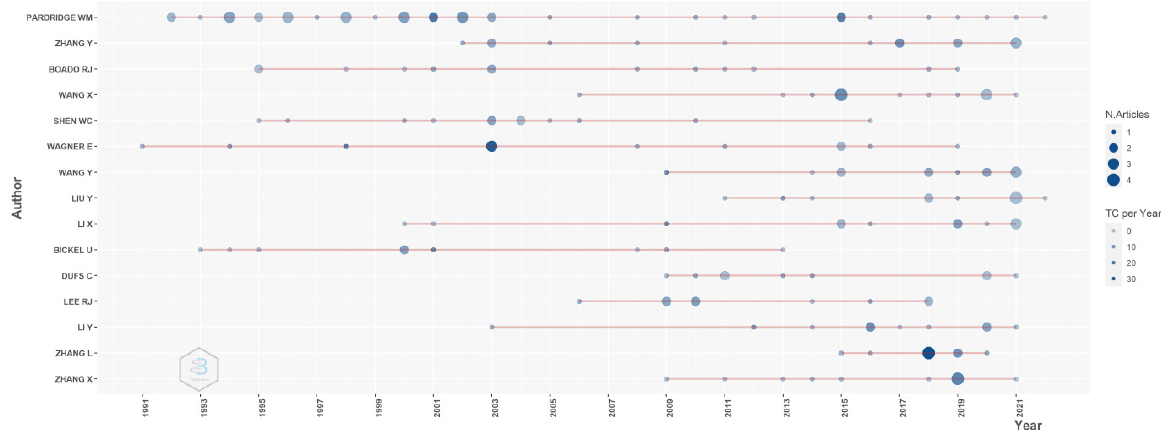
8 of 21 Figure 4. Most relevant affiliations. Source: Authors’ elaboration using the Bibliometrix R-package. Figure 5 depicts the evidence of the most relevant authors. Pardridge, who exam- ined the use of transferrin receptors in the human blood–brain barrier to facilitate drug delivery to the brain, is the most relevant author in the literature. Pardridge characterized transferrin receptors in the human brain using monoclonal antibodies in 1987. Pardridge selectively transported antitransferrin receptor antibodies to the blood–brain barrier in rats in 1991. Furthermore, Pardridge, Zhang, and Boado also contributed vitally to the research on transferrin receptor-mediated drug delivery. Figure 5. Most relevant authors. Source: Authors’ elaboration using the Bibliometrix R-package. Figure 6 represents the evidence of the selected author-specific publications. It is clear from the evidence that Pardridge and Wagner are the most active researchers in the field of transferrin/transferrin receptor-mediated drug delivery to targeted sites. Par- dridge worked on delivering various therapeutic agents to the brain using transfer- rin/transferrin receptors. He has been the most active researcher from 1992 until present, and he has contributed more than 40 papers. Wagner is one of the earlier researchers who